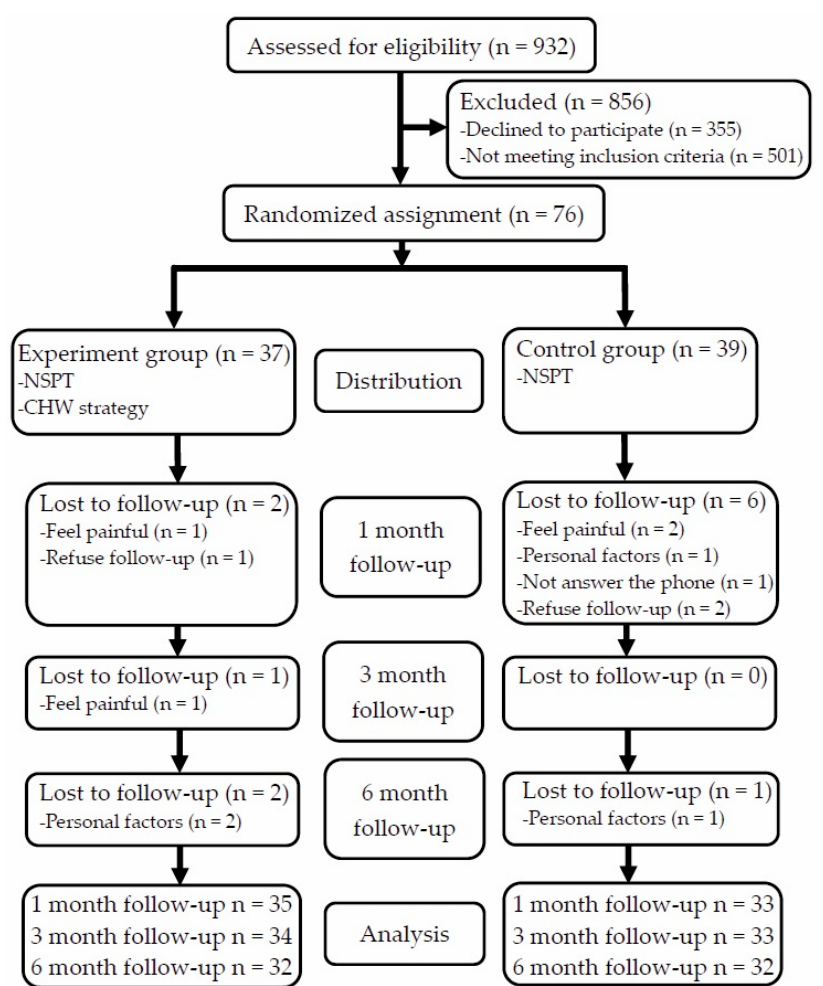
Figure 1. CONSORT flow chart of participant recruitment.